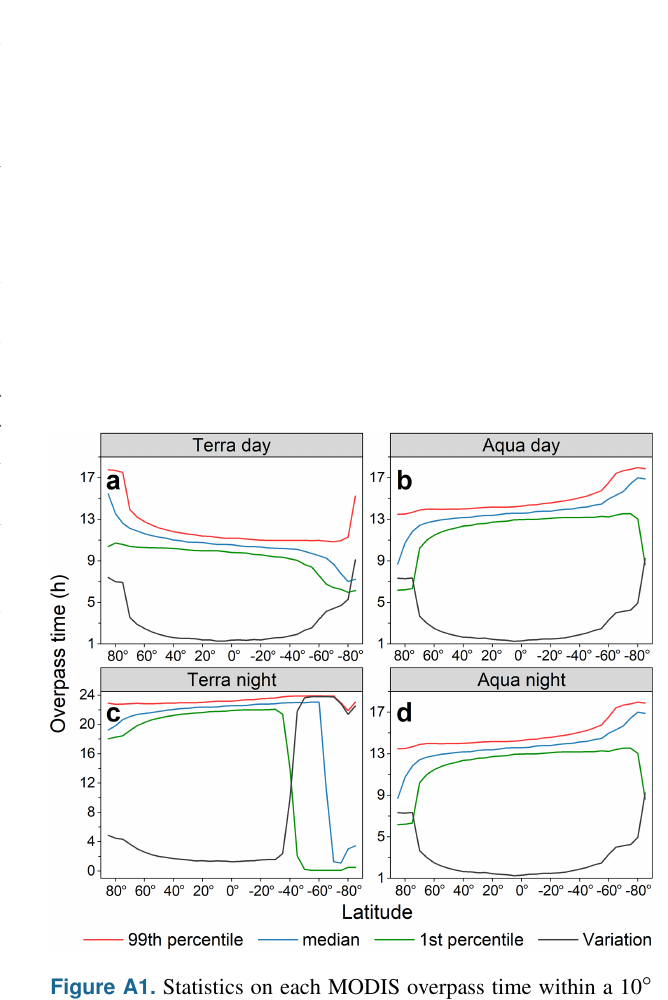
Figure A1. Statistics on each MODIS overpass time within a 10 ◦ interval from 2003 to 2019. Each subplot displays the 99th per- centile, median, first percentile, and the associated variation (the 99th percentile minus first